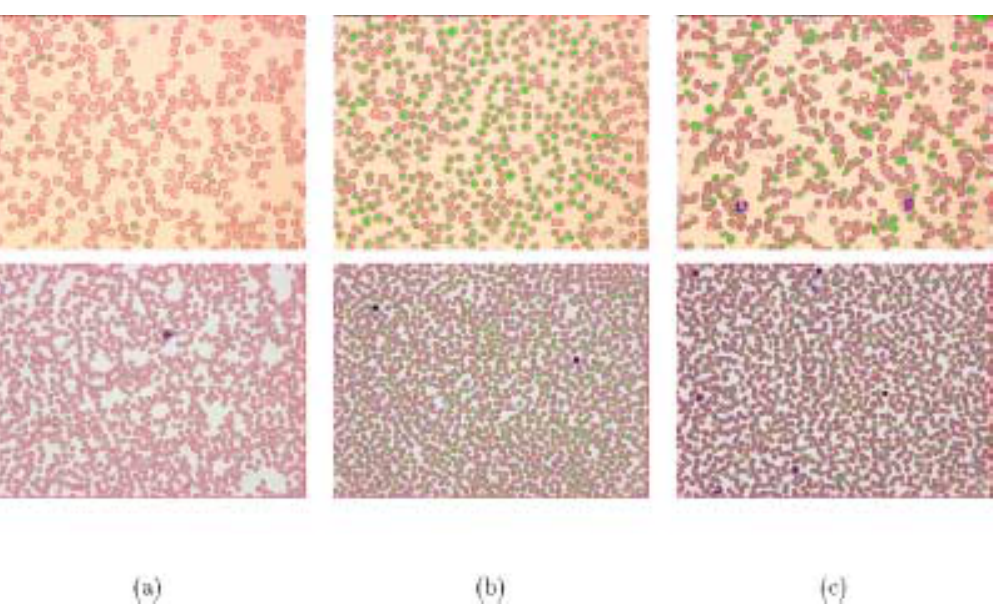
Fig. 7. Example of three fields of a blood smear (first row × 25 and second row × 16): (a) Spread area, (b) optimal area and (c) thick area. In green, clear centers and in red, boundaries of cells. This figure can be viewed on http://www.esacp.org/acp/2003/25-1/angulo.htm.